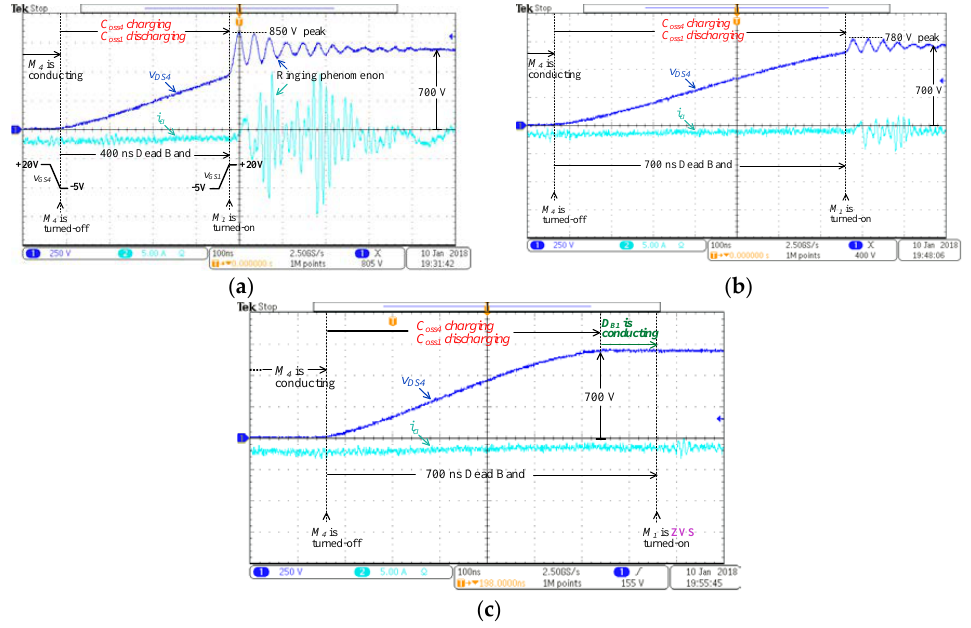
Figure 24. Effects of dead band on turn-off behavior of S 4 around zero crossing of the unfiltered line current (symbols are as defined in Figure 22 and v DS and i a are recorded by Tektronix MSO3034 oscilloscope, Tektronix P5205A high voltage differential probe, Tektronix TCP404XL current probe, Tektronix TCPA300 current probe amplifier): ( a ) 400 ns dead band; ( b ) 700 ns dead band; and ( c ) 700 ns dead band with ZVS turn-on of M 1 .